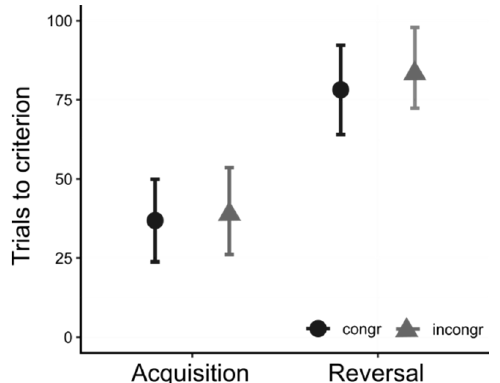
Figure 6. Results of Exp. 3: Chicks required significantly more trials (about 40) to complete the re ‐ versal than the acquisition. The congruency of the association did not seem to affect performance. In the incongruent conditions, chicks required on average 3 extra trials in the acquisition and 6 extra trials in the reversal; these differences were not